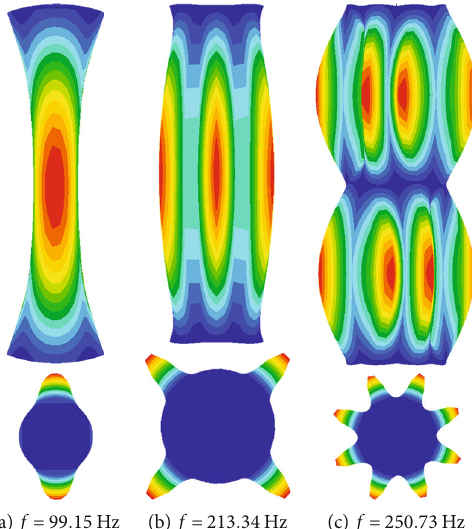
Figure 2: Typical wet mode shapes of the cylinder.